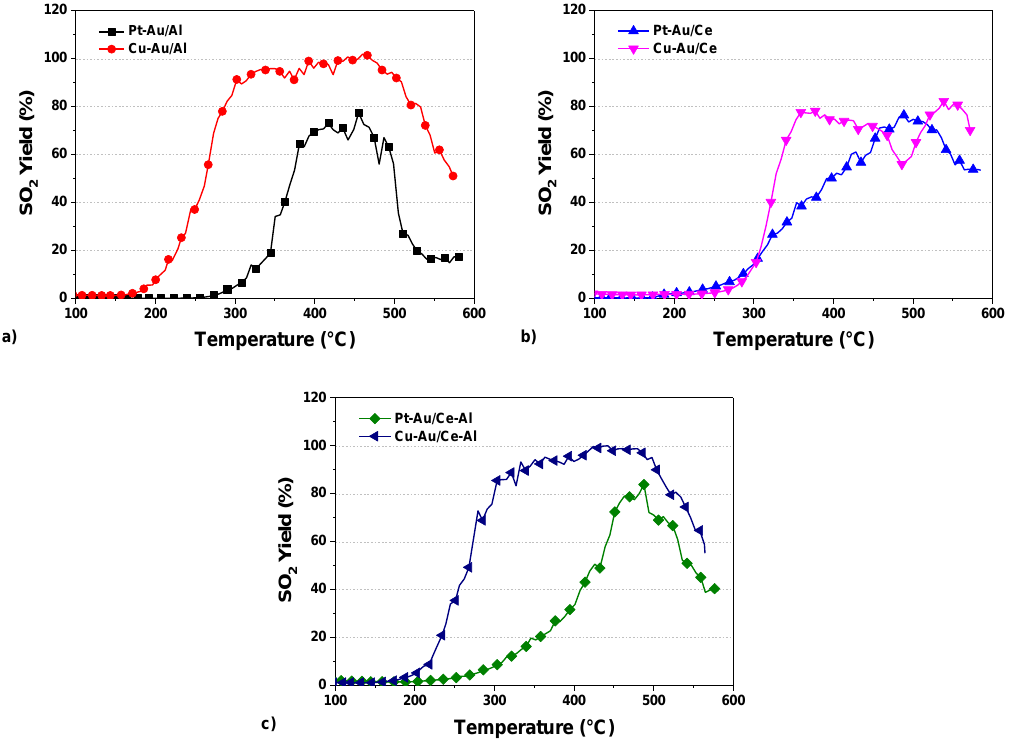
Figure 10. The SO 2 yields over Pt–Au and Cu–Au supported on ( a ) γ -Al 2 O 3 , ( b ) CeO 2 , and ( c ) CeO 2 – Al 2 O 3 in the oxidation of DMDS (the same experimental conditions as in Figure 9).